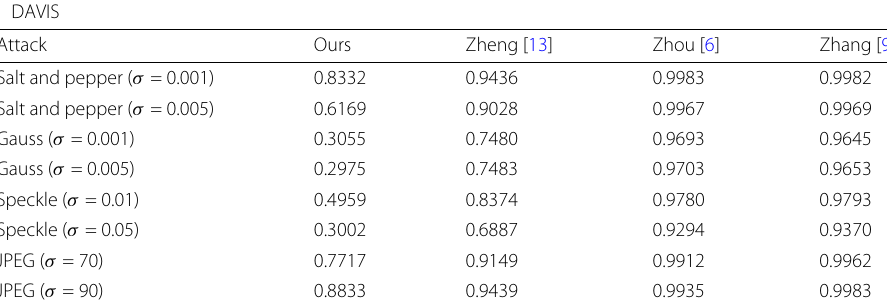
Table 5 Robustness of different methods